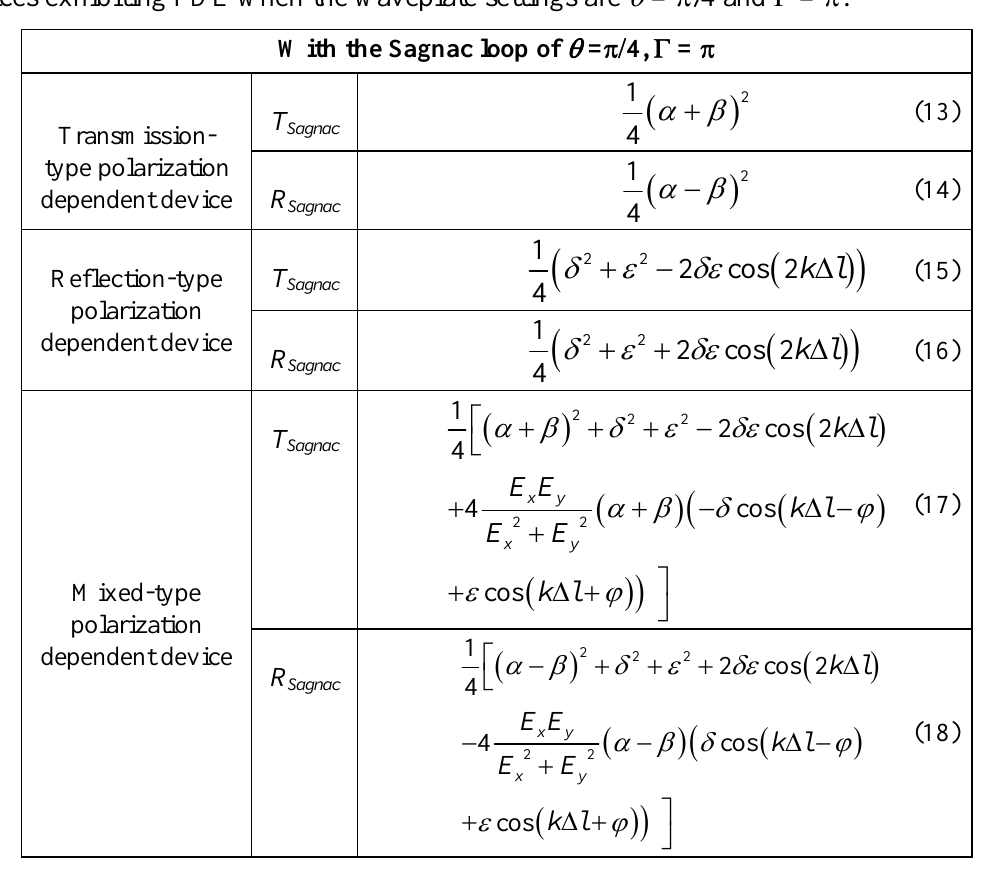
Table 3. The transmittance and reflectance of a Sagnac interferometer with various nested devices exhibiting PDL when the waveplate settings are  =  /4 and  = 